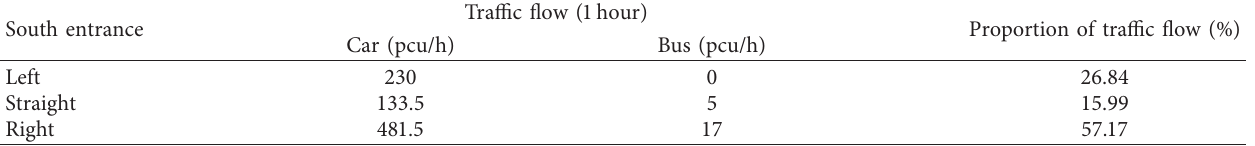
Table 6: Morning peak hour traffic flow at the intersection of Tieji Road and Heping Avenue.